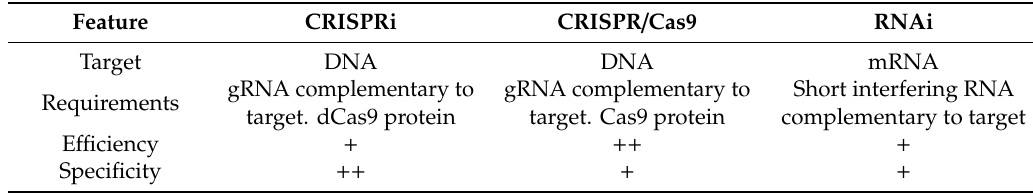
Table 2. Comparison of CRISPRi, CRISPR / Cas9 and RNAi methods for knock-down of eukaryotic genes. + indicates lower levels, ++ indicates higher